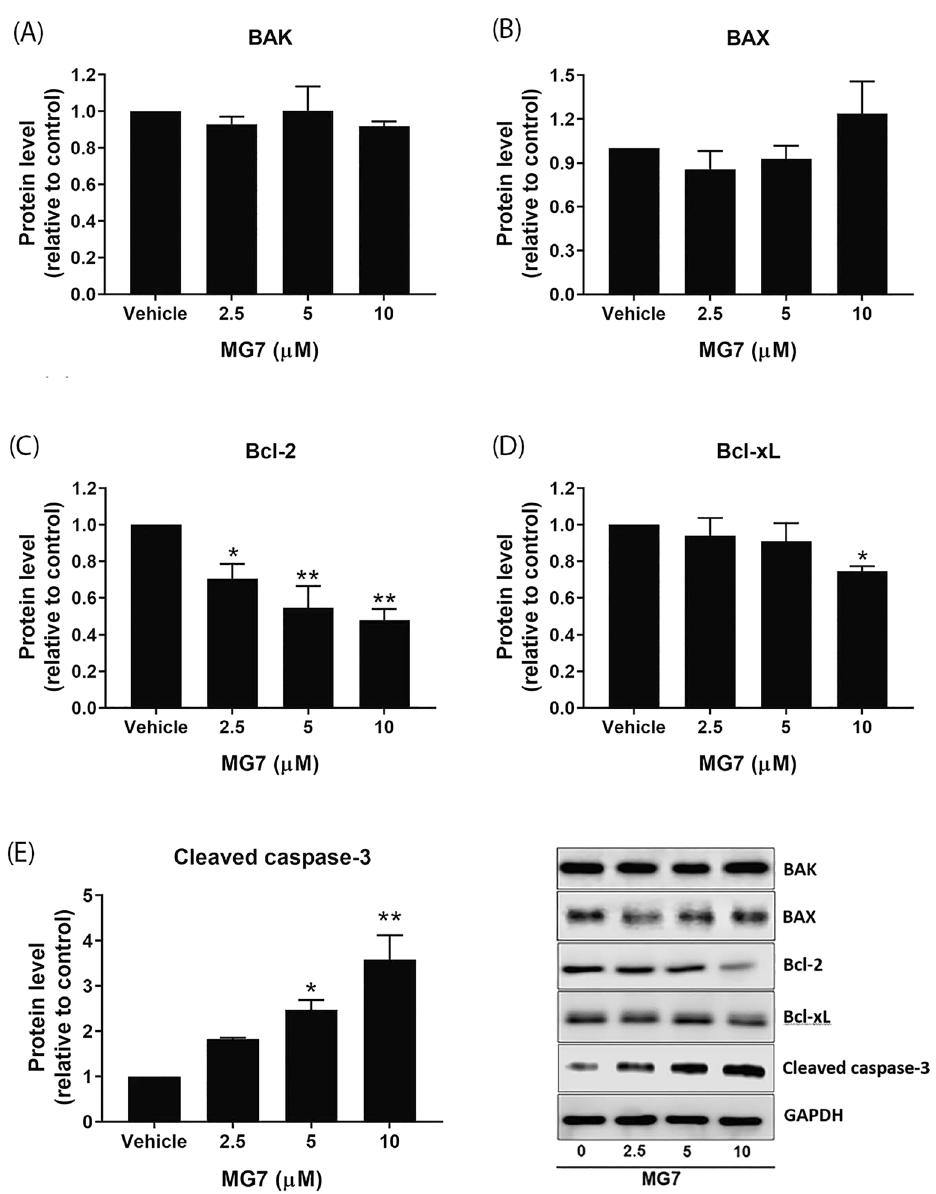
Figure 5. Effects of MG7 on the protein expression of Bcl-2 family members in HCT-116 cells. The cells were treated with MG7 at concentrations of 2.5, 5, and 10 µM for 24 h. The expression levels of ( A ) BAK, ( B ) BAX, ( C ) Bcl-2, ( D ) Bcl-xL and ( E ) cleaved caspase-3 proteins were determined using western blot. Data are expressed as mean ± SEM of three independent experiments. * P < 0.05 and ** P < 0.01 compared to vehicle control (0.2%